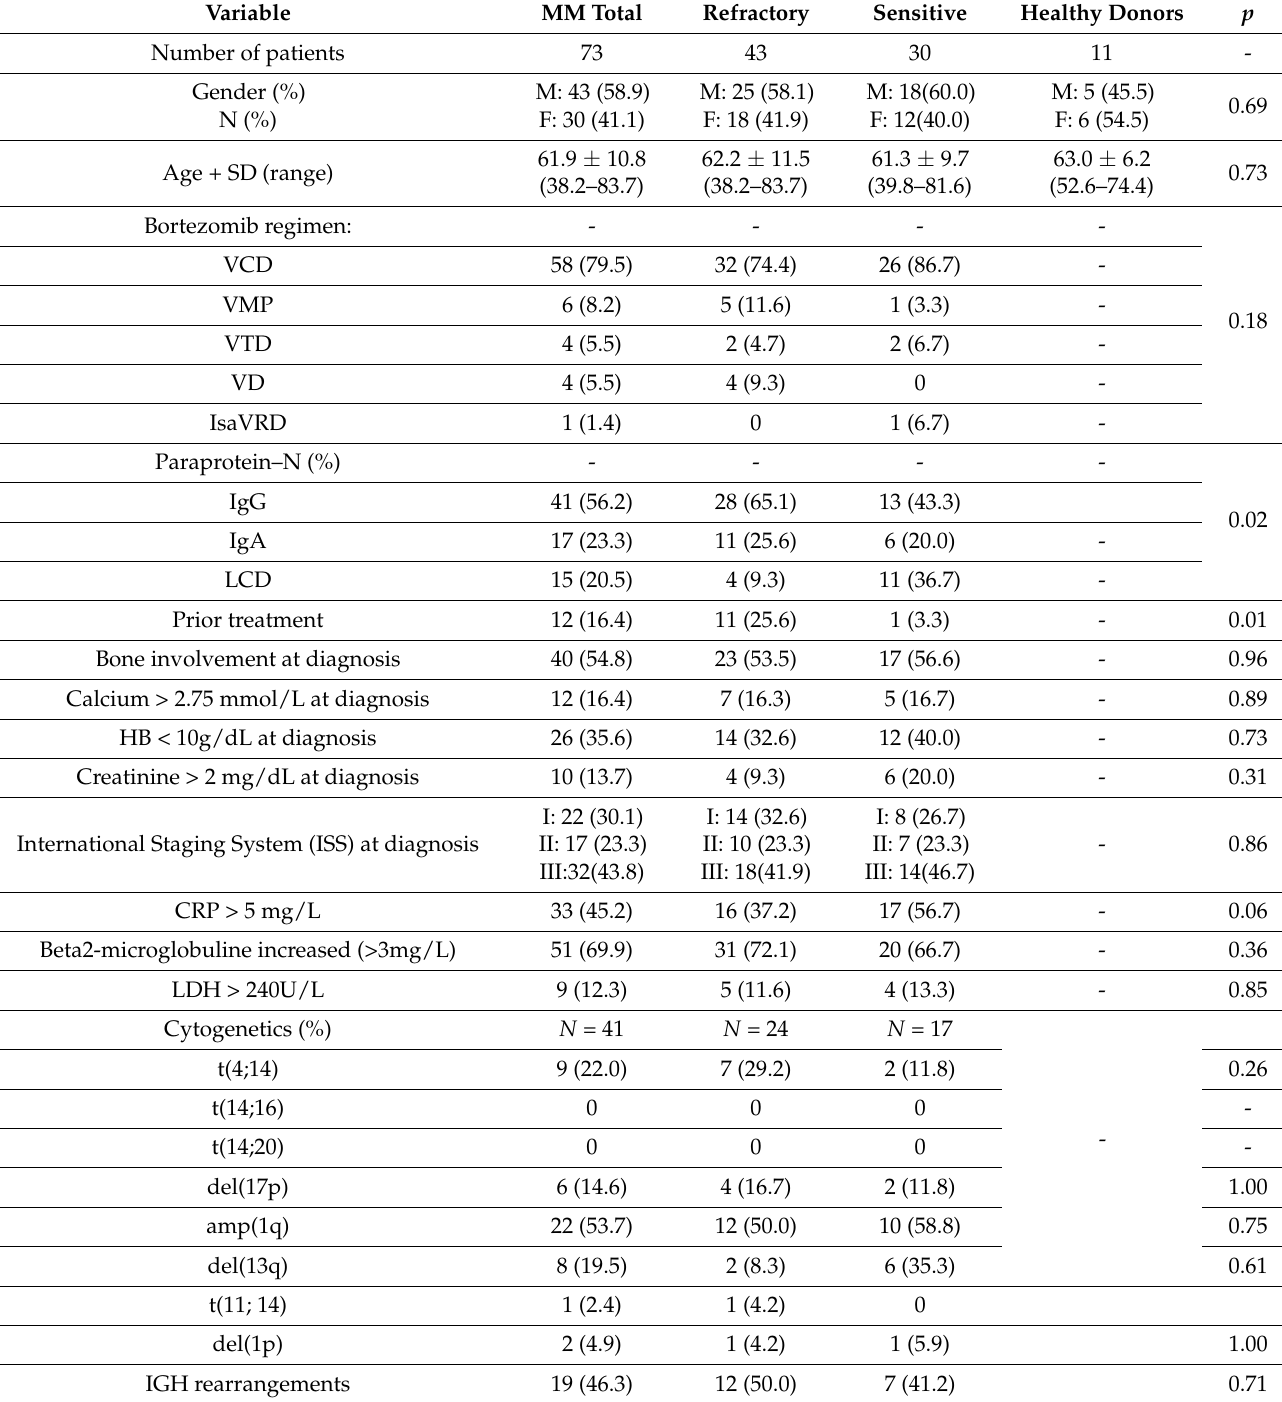
Table 1. The characteristics of the MM patients treated with bortezomib-based therapy and healthy donors. Data are presented as frequency, percentage (%) unless otherwise